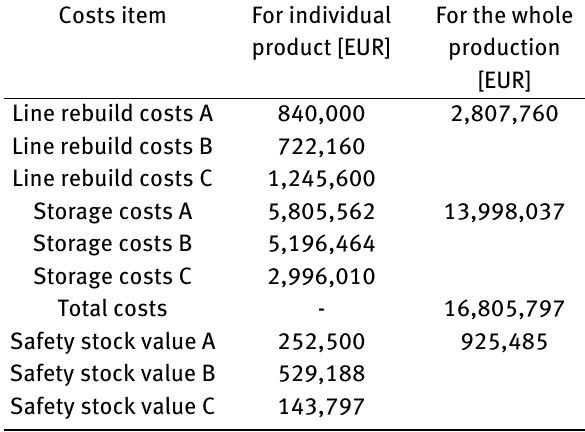
Table 5: Production costs for production planning according to forecasts.